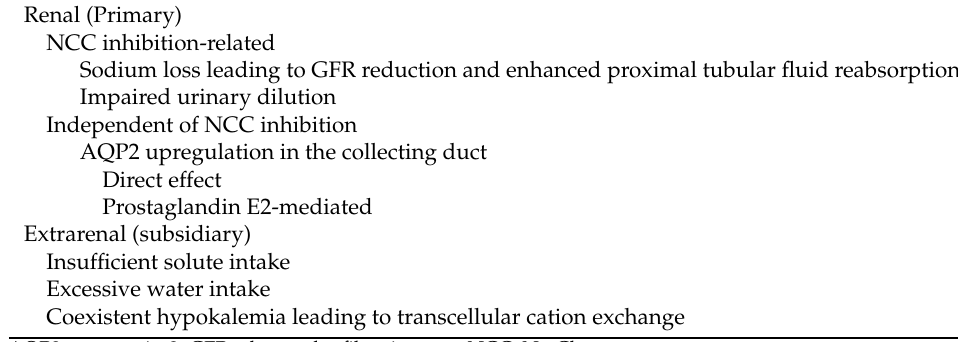
Table 2. Mechanisms of thiazide-induced